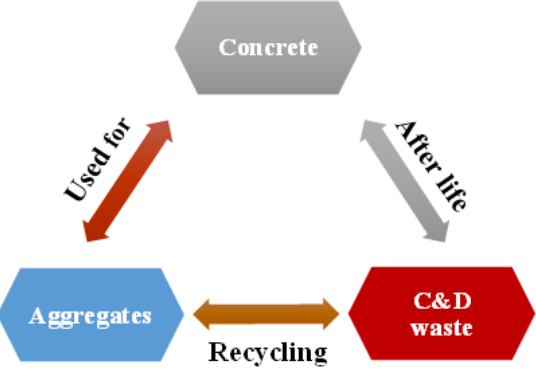
Figure 1. Schematic representation of the recycling process for the aggregate.